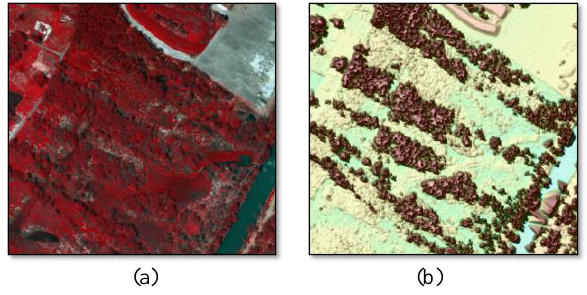
Figure 7(a), (b). Comparison of aerial photograph (a: left) with LiDAR image (b: right). Both images acquired for 10 th July